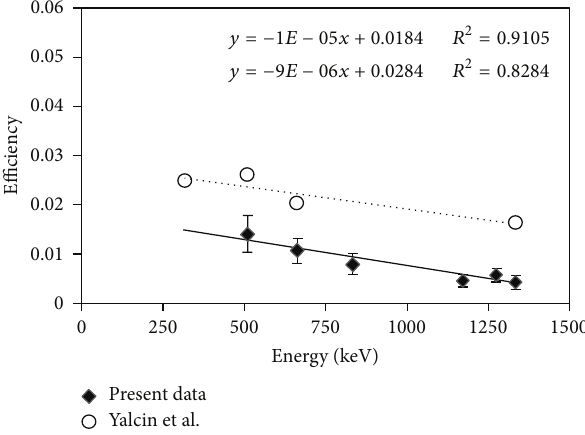
Figure 7: Comparison of measured and calculated detection effi- ciency of NaI(Tl) detector (source placed at 10cm distance to the detector face).